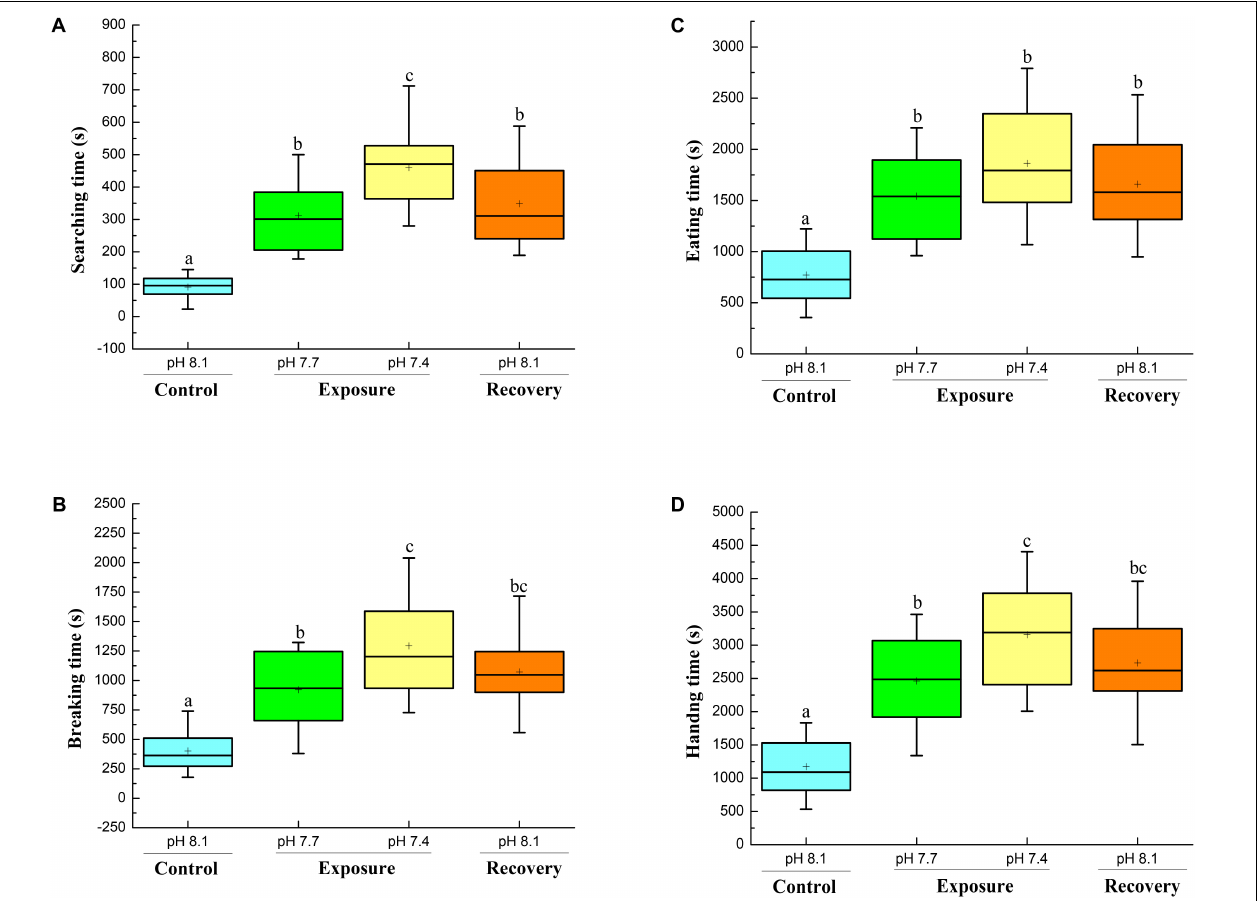
FIGURE 5 | Foraging behavior of C. pagurus at different pH conditions: Searching time (A) , Breaking time (B) , Eating time (C) , and Handling time (D) of C. pagurus at different pH conditions following four successive treatments. Values are means ± SE. Different letters indicate significant differences compared to initial control pH conditions ( P <